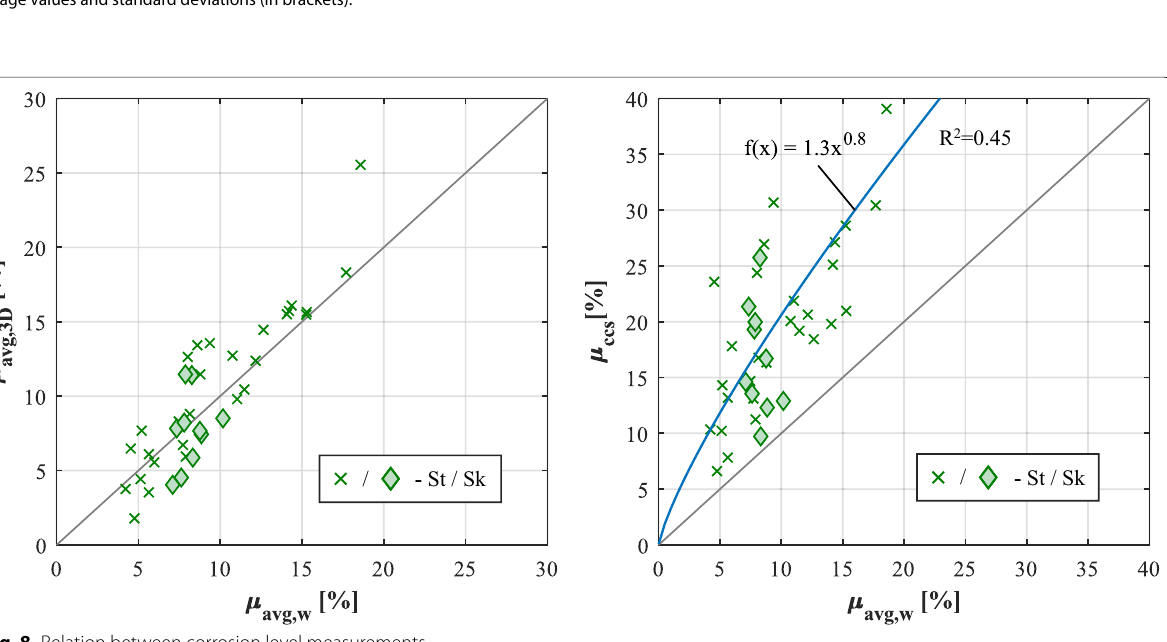
Average values and standard deviations (in brackets).